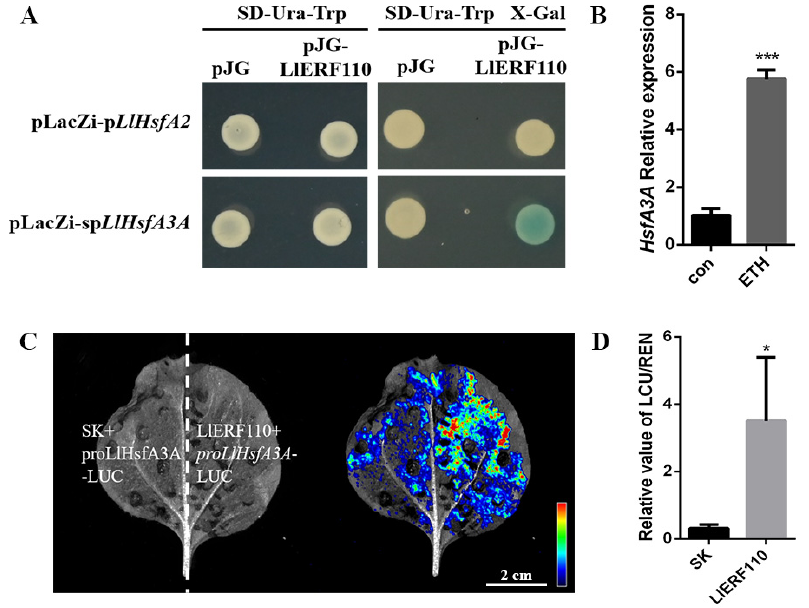
Figure 7. LlERF110 binds to the promoter of LlHsfA3A and activates its transactivation activity. ( A ) The bait (pLacZi- pLlHsfA2 or spLlHsfA3A ) and prey (pJG or pJG-LlERF110) constructs were cotransformed into the yeast strain Y187. The baits transformed with the prey pJG were used as negative control. Interaction between bait and prey was determined by cell growth on SD/-Ura-Trp containing X-Gal. ( B ) Relative expression of LlHsfA3A in lily leaves after exogenous 2 ppm ETH treatment measured using qRT-PCR. ( C ) The dual-luciferase reporter assay was used to detect the interaction between LlERF110 and the LlHsfA3A promoter in N. benthamiana leaves. A 1020-bp fragment of LlHsfA3A promoter was used in this assay. Empty vector pGreenII 62-SK (SK) and ProLlHsfA3A :LUC was used as negative control. Suspensions of A. tumefaciens contained different vectors that were mixed and infiltrated into N. benthamiana leaves, and LUC signals were detected 72 h after infiltration. Bar: 2 cm. ( D ) The ratio of LUC/REN of the empty vector (SK) co-transformed with the proLlHsfA3A -LUC vector was used as the calibrator (set as 1). Three independent experiments were performed. T -test analysis of variance was employed to identify treatment means that differed statistically. Samples with different stars are significantly different; * p < 0.05, and *** p <